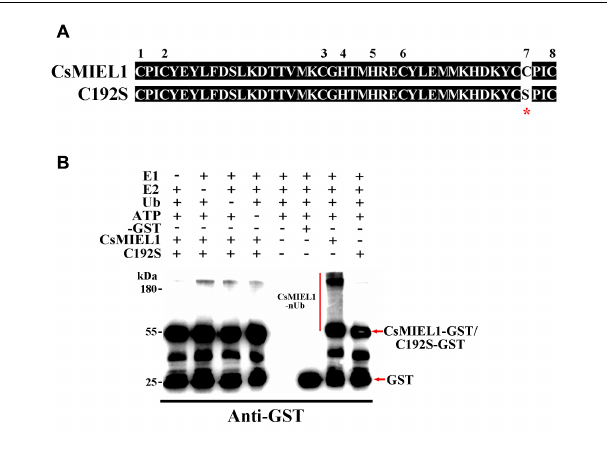
FIGURE 5 | Verification of the activity of CsMIEL1. (A) Comparison of the amino acid sequence of CsMIEL1 and CsMIEL1-C192S. (B) In vitro ubiquitination analysis of CsMIEL1 and CsMIEL1-C192S. *Sited-directed mutagenesis position.